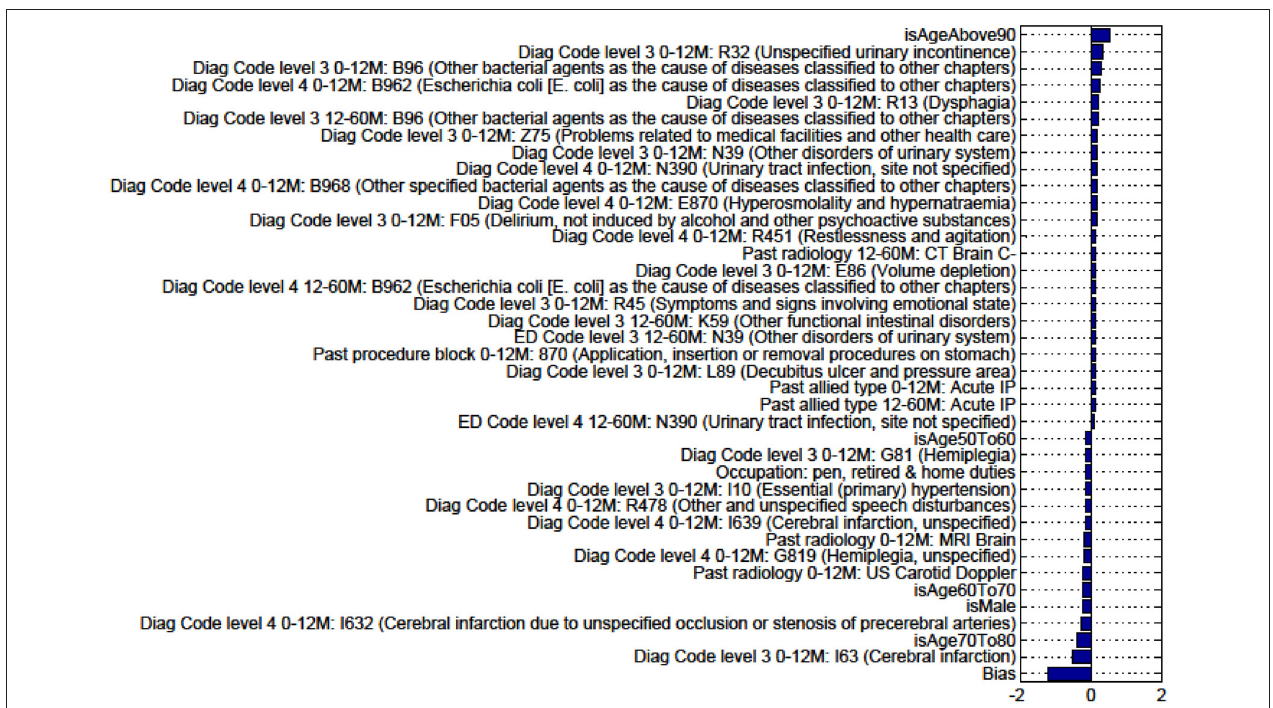
FIGURE A7 | Factors for prediction of Discharge to Nursing Home vs Rehabilitation for the sub-cohort of ischemic stroke patients.